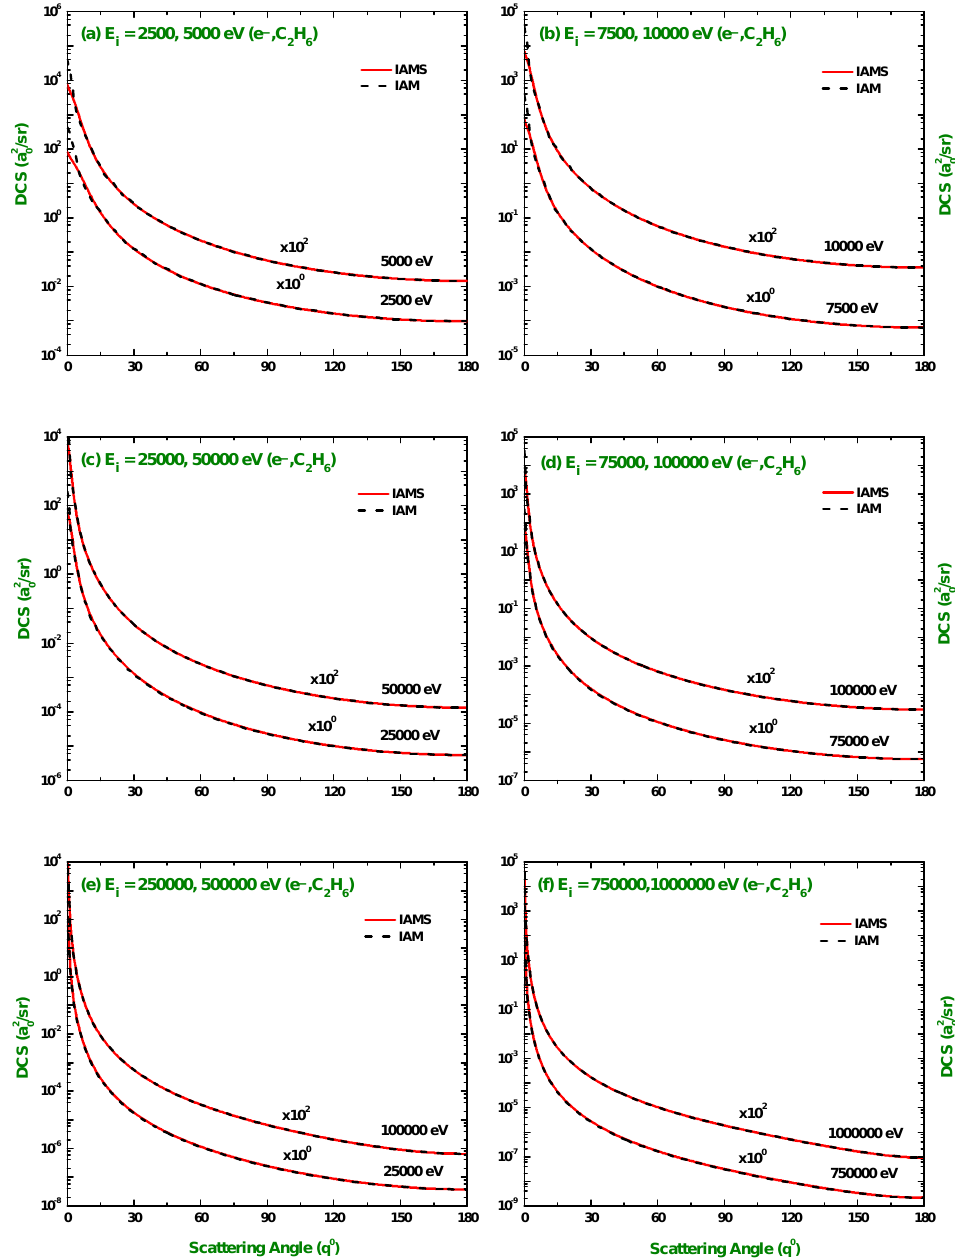
Figure 4. DCS ( a 2 / sr ) for the elastic scattering of electrons from C 2 H 6 at energies of 2.5 keV to 1 MeV. 0 Theoretical works: References in Figure